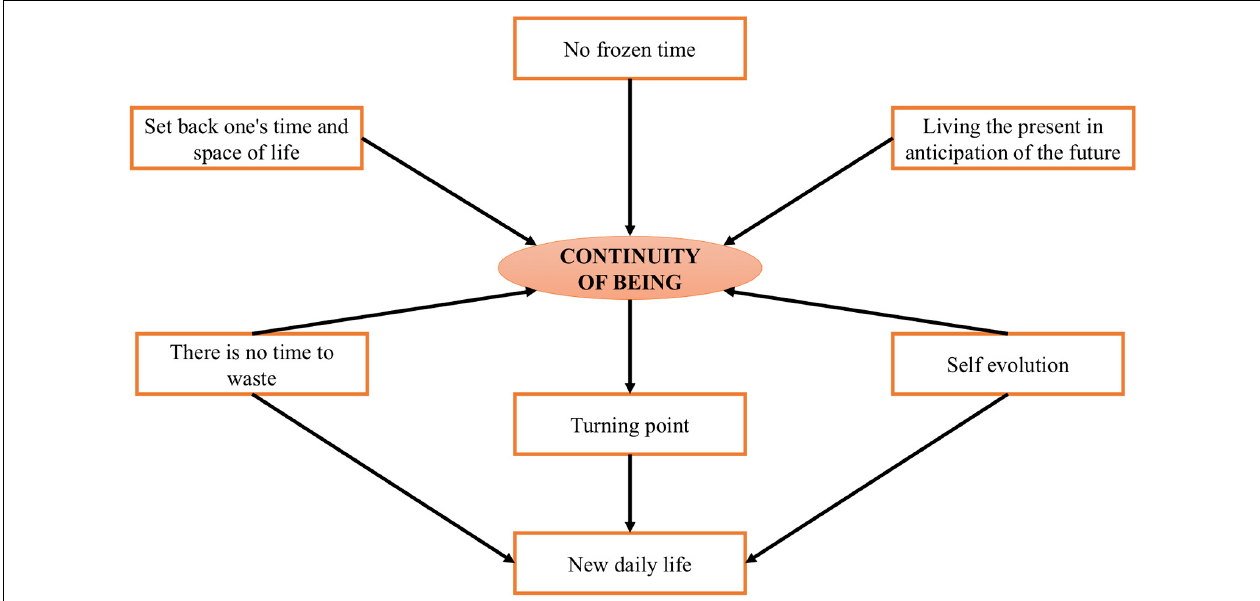
FIGURE 1 | Core category, continuity of